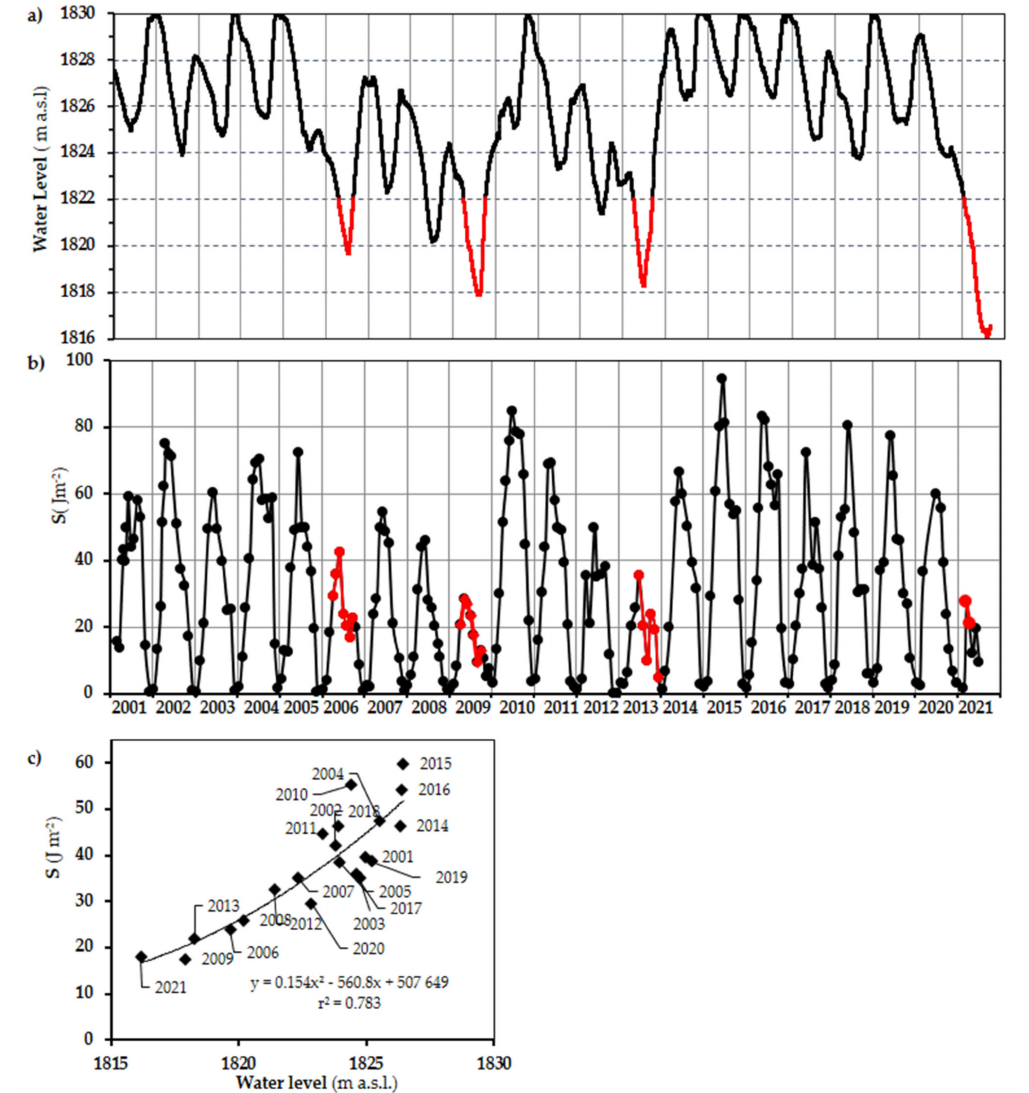
Figure 3. Time variations in VB during 2001–2021 o: ( a ) water level (daily resolution, m a.s.l), ( b ) stability of stratification (S, J m − 2 ), and ( c ) relationship between mean S and minimum water level during the stratification periods. Red lines outline the four years with extraordinary minimum water levels (2006, 2009, 2013, and 2021) in some of the